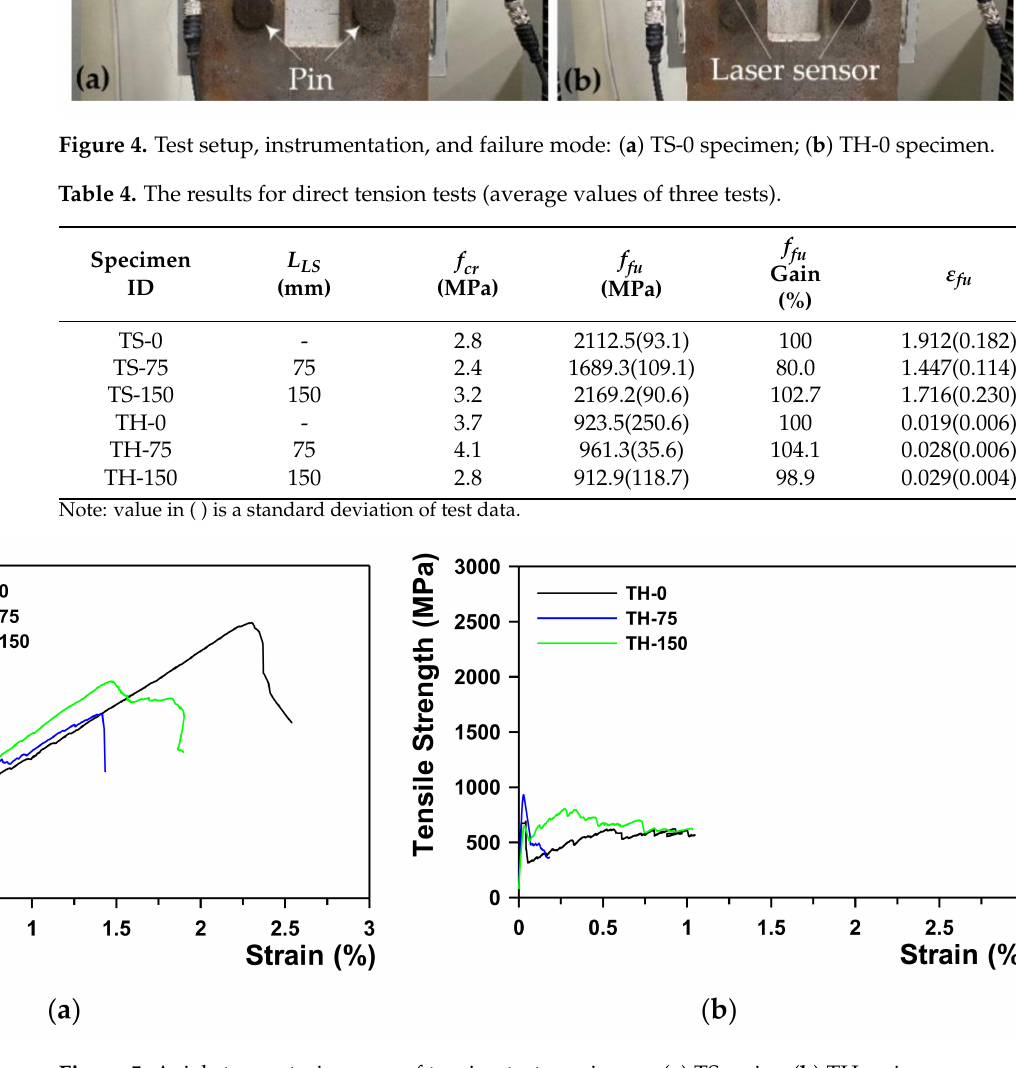
Figure 5. Axial stress–strain curve of tension test specimens: ( a ) TS series; ( b ) TH series. The ultimate tensile strength ( f fu ) of the specimens was greatly influenced by the type of textile and the lap-splice lengths. The tensile tests revealed that the direct tensile strength of the sand-coated textile without a lap splice (TS-0 specimen) was 2112.5 MPa and the ultimate tensile strain ( ε fu ) was 1.912%. For L LS of 75 mm and 150 mm, the average value of f fu was 1689.3 MPa and 2169.3 MPa, respectively, and that of ε fu was 1.447% and 1.716%, respectively. Compared to the TS-0 specimen, f fu was about 80% when L